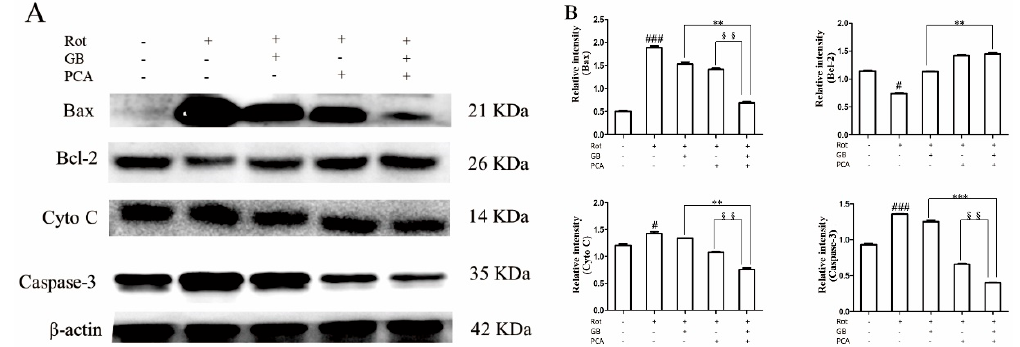
Figure 4. Combined effects of GB and PCA on the change in protein levels in Rot-induced PC12 cells. Rot-induced PC12 cells were treated for 48 h with 25 μ M GB or 0.6 mM PCA alone or in combination at the specified concentration. ( A ) The pictures of western blot. ( B ) Intensity analysis of western blot. The data represent the means ± SDs. # p < 0.05 and ### p < 0.001 vs. The normal group, ** p < 0.01 and *** p < 0.001 vs. The GB-treated group, §§ p < 0.01 vs. The PCA-treated